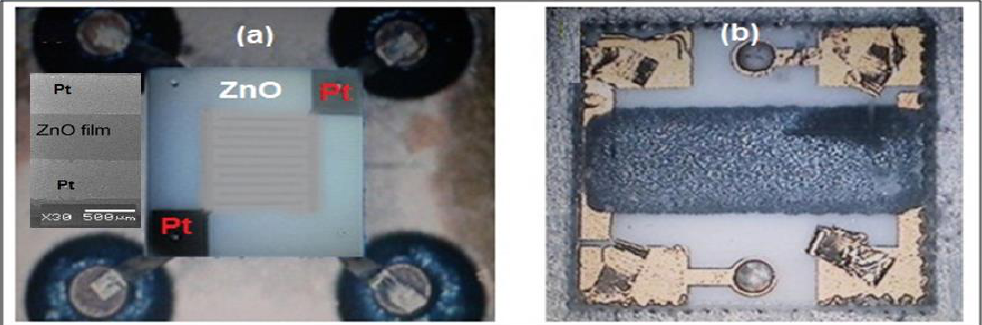
Fig.3: Sensing elements dimension of 4 mm x4 mm (a)Pt/ZnO/Pt (b)micro heater